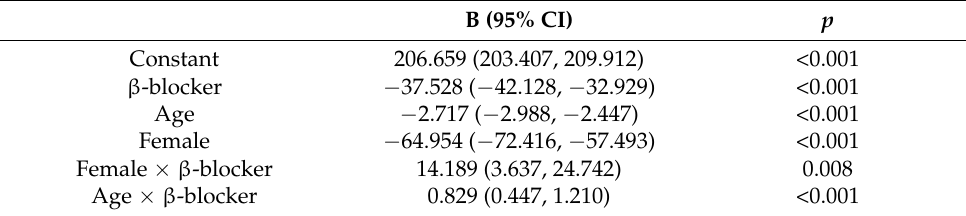
Table A3. Results of the linear regression model with maximum power as the